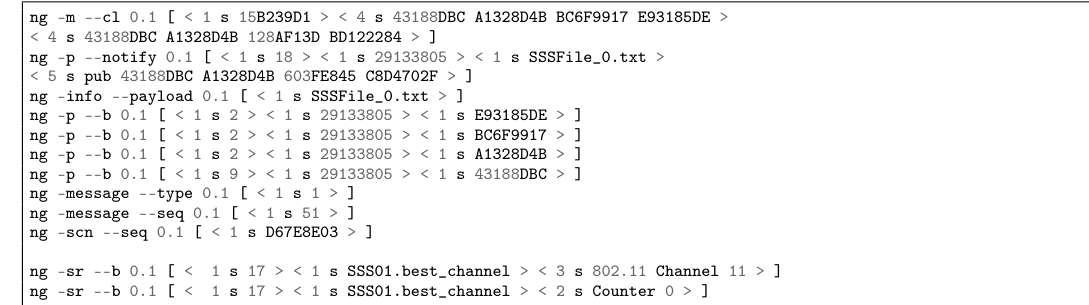
Figure 16. Log of SSS indicating for RMS the best channel to configure Wi-Fi access point in the region.